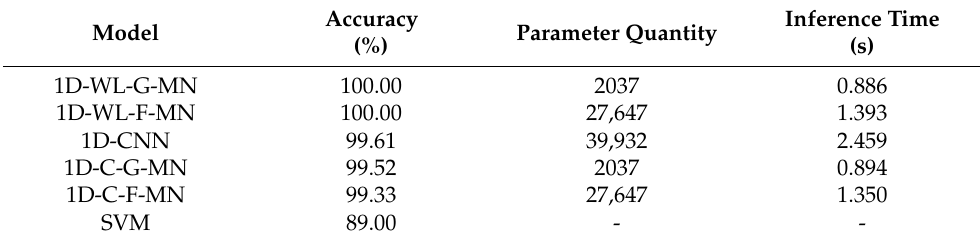
Table 7. Model performance comparison.